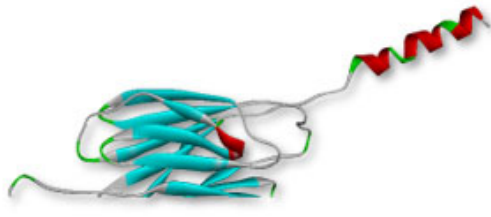
Figure 1. The tertiary structure of MPXVgp169 virulent